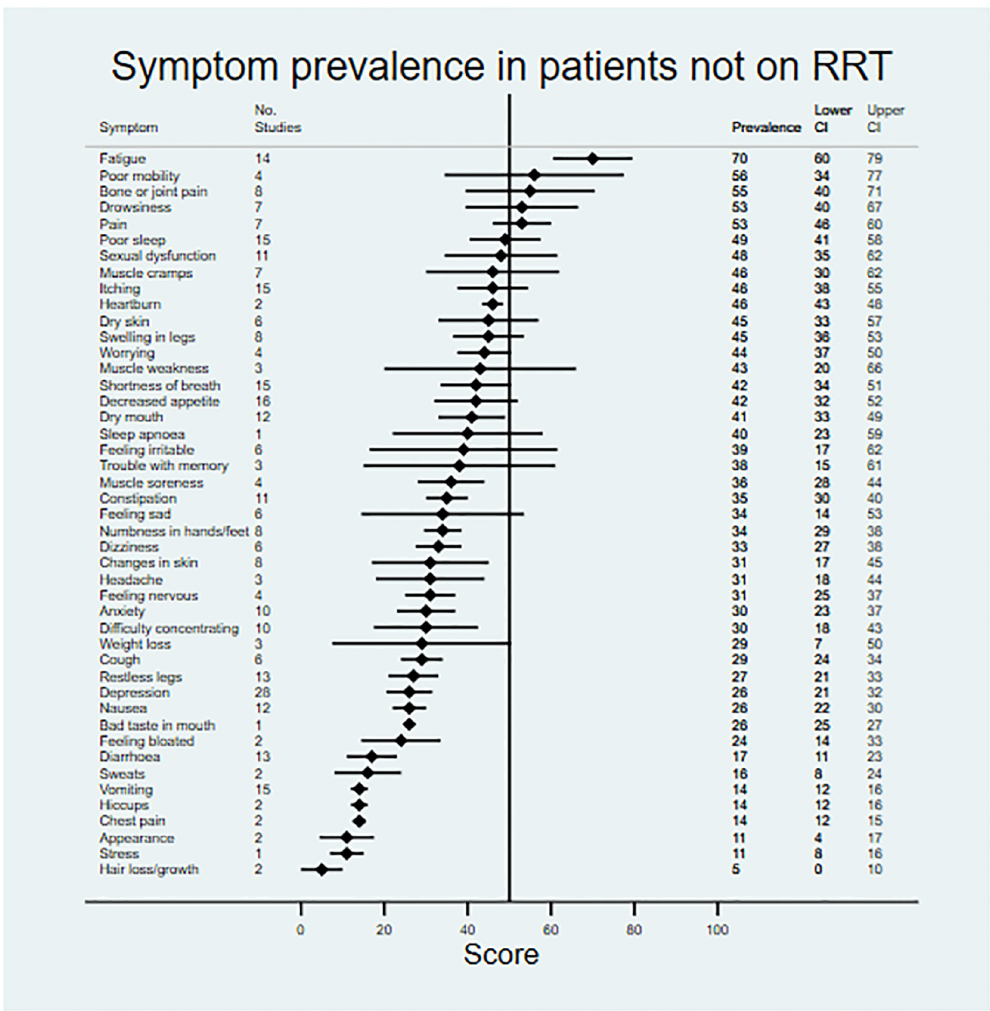
Fig 2. Pooled prevalence of patient-reported symptoms across included studies for patients not on renal replacement therapy (RRT).